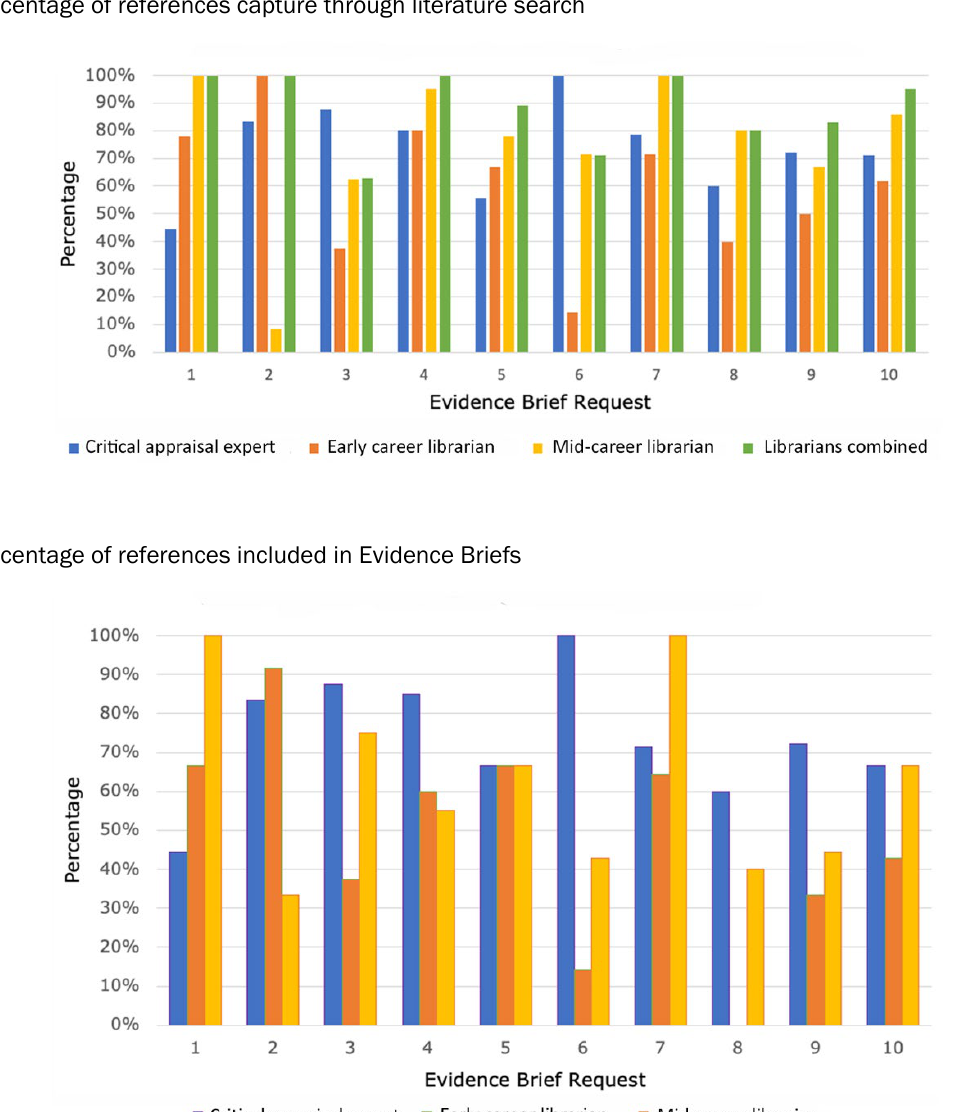
Figure 2 Percentage of references capture through literature search